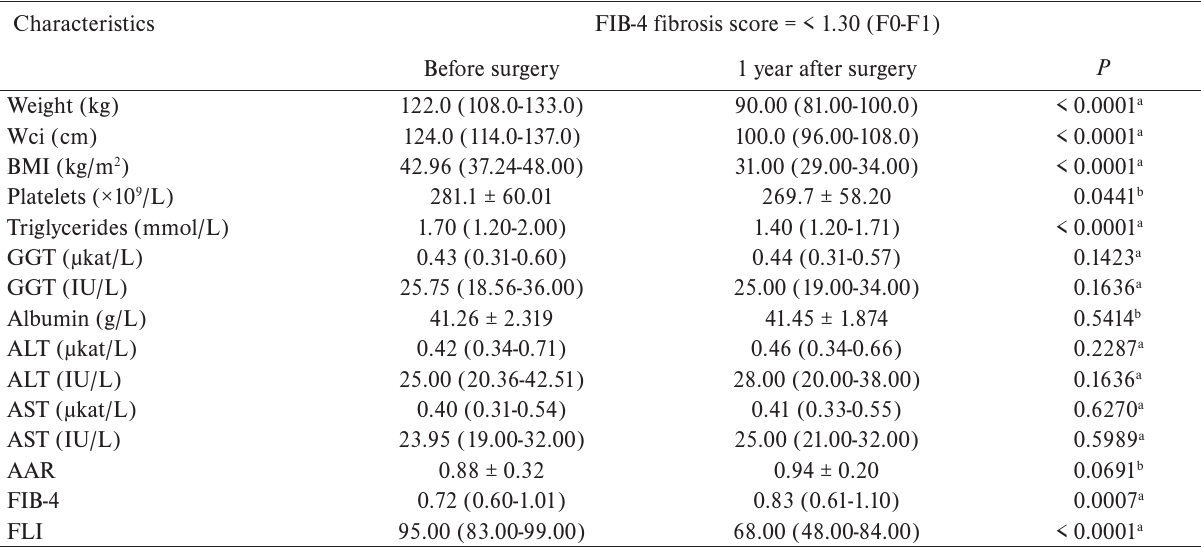
Table 4. Paired value analysis of basic changes in clinical and biochemical characteristics of morbidly obese patients before